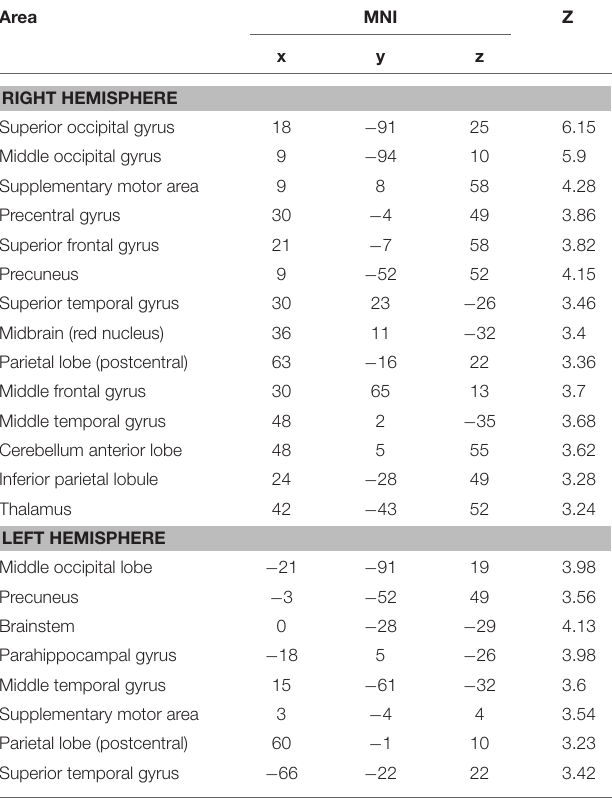
TABLE 1 | Activation peaks (Montreal Neurological Institute coordinates) obtained for Line Vertical judgment > Line Color judgment ( P < 0.001 uncorrected; cluster size >